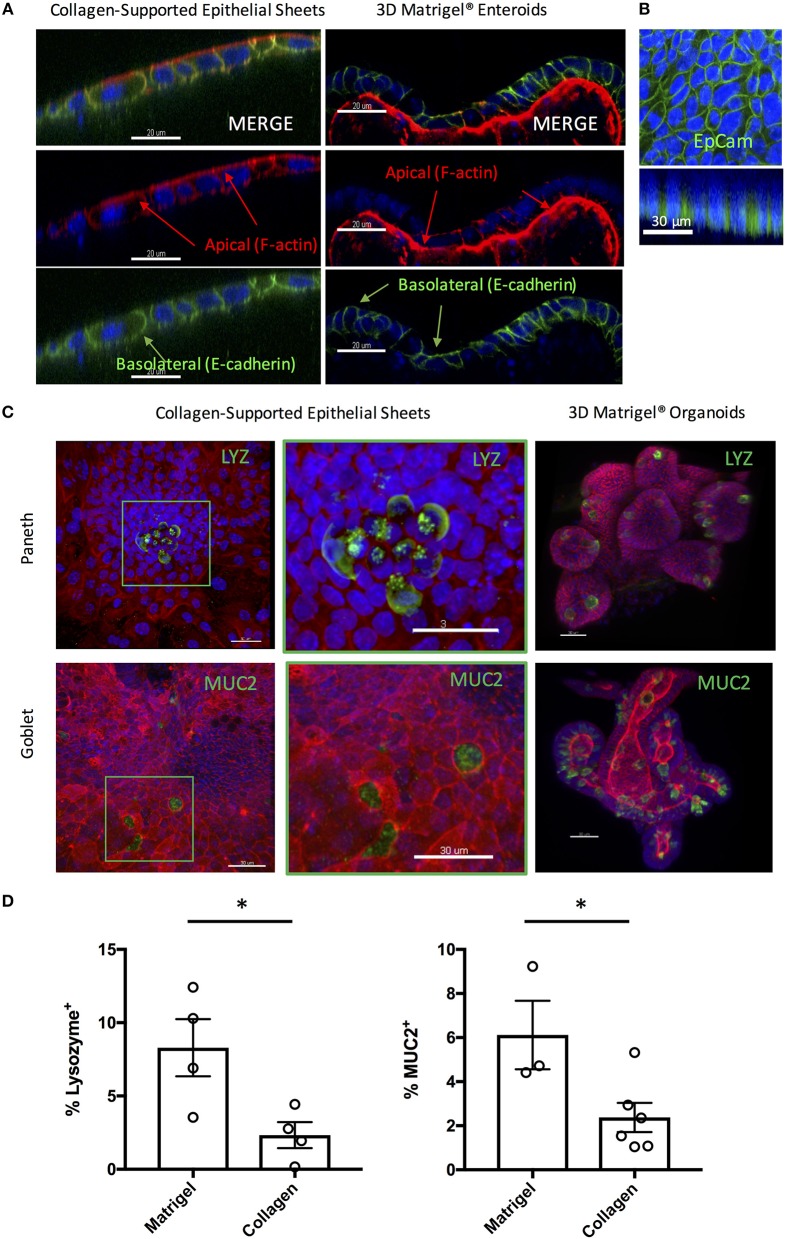
Collagen-supported epithelial sheets retain features of a fully differentiated epithelium. Murine (C57Bl/6) collagen-supported epithelial sheets and Matrigel® embedded enteroids were cultured for 7–8 days, fixed, and stained for confocal microscopy. For (A) and (B) Z stack images were acquired and appropriate orthoslices of a single plane are shown to demonstrate staining localization. (A) Confocal images showing apical enrichment of F-actin (red) and basolateral localization of E-cadherin (green; scale bars = 20 μm). (B) Confocal images showing lateral expression of EpCAM (green; scale bar = 30 μm). (C) Confocal images showing localization of Paneth cells (LYZ; green) and goblet cells (MUC2; green) in collagen supported-epithelial sheets and Matrigel®-grown enteroids (scale bars = 30 μm). (D) Graphs depict the proportion of enteroid epithelial cells expressing LYZ (Paneth cells; P < 0.05 by Student's unpaired t-test) or MUC2 (Goblet cells; P < 0.05 by Student's unpaired t-test) in 3D enteroids and collagen-supported epithelial sheets, respectively. Each data point indicates the mean of an individual experiment. Pooled data from at least three independent experiments per condition are shown. Mean ± SEM is shown. *indicates p<0.05.